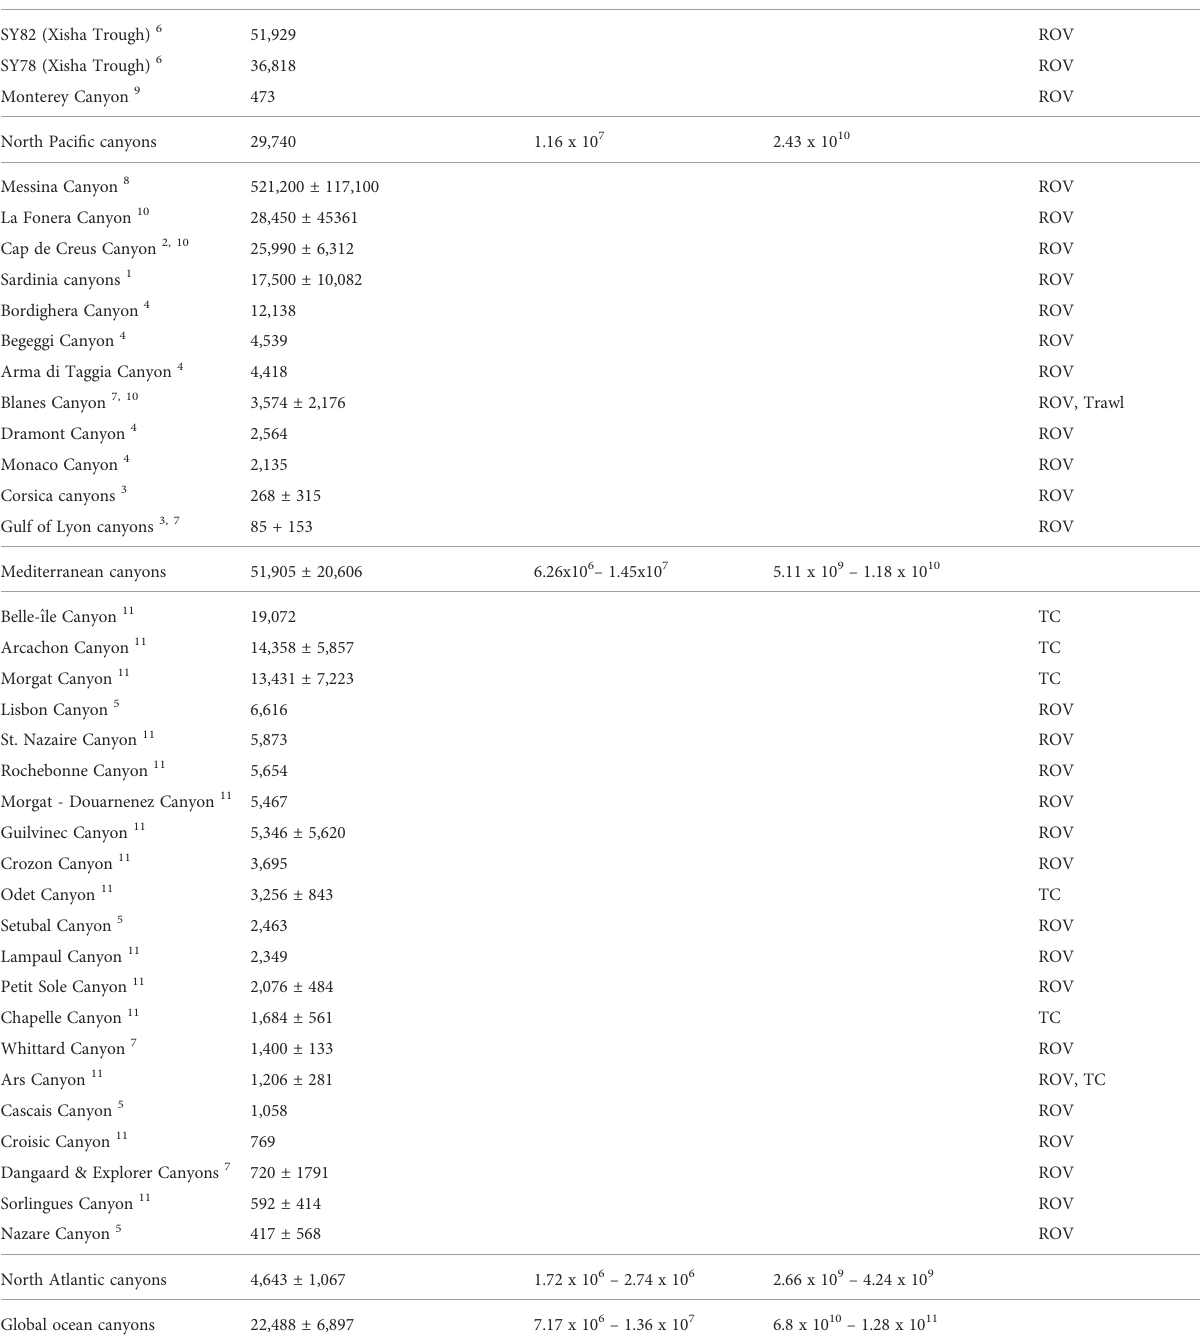
TABLE 3 Litter densities transformed to n km -2 with SD where available. Canyon